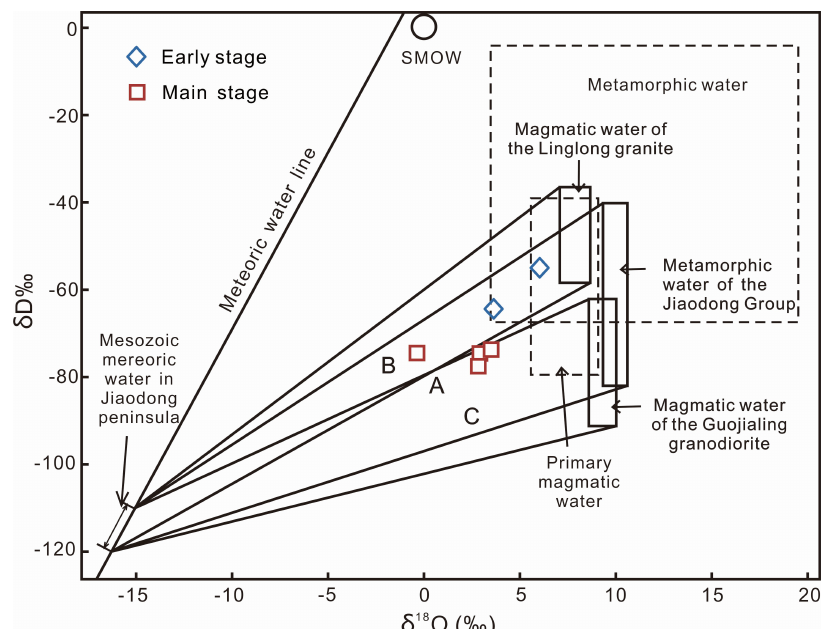
Figure 13. The H–O composition of ore-fluids in early and main stages: Area A means metamorphic water of the Jiaodong Group mixed with meteoric water; Area B means magmatic water of the Linglong granite mixed with meteoric water; and Area C means magmatic water of the Guojialing granite mixed with meteoric water. The base map is modified after Guo et al. (2014)